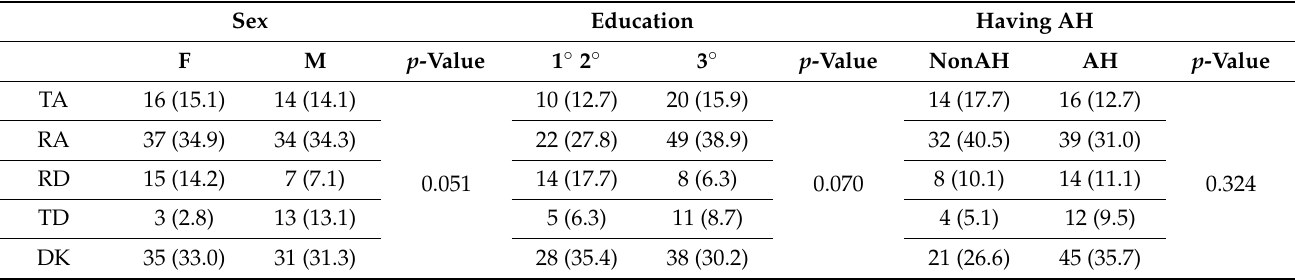
Table 10. Aging as a factor that increases the incidence of hypertension by gender, education, and having hypertension (N = 205).